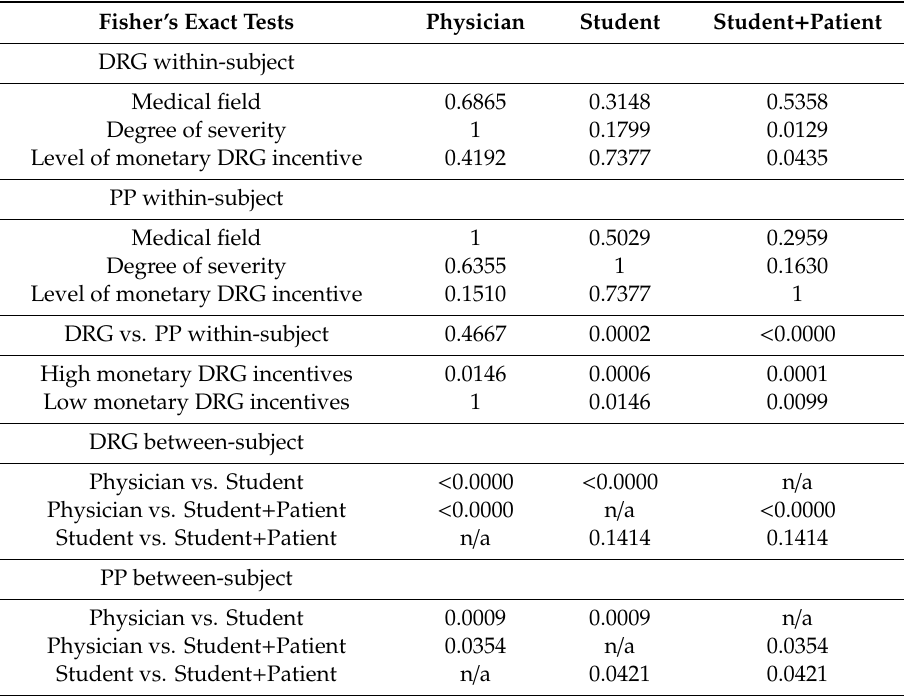
Table A9. Results of Fisher’s exact tests for the entire subject pool *.